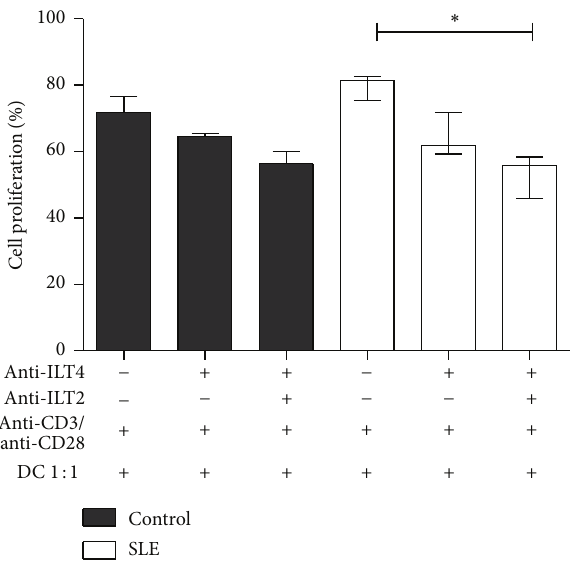
Figure 5: Effect of ILT4 engagement on the immunogenic activity of DC from patients with SLE. Mature DC were incubated in the presence or absence of anti-ILT4 and/or ILT2 agonistic mAb (aILT4/ILT2) and then cocultured with allogenic CFSE labeled PBMC, in flat-bottomed 96-well plates precoated with a mixture of anti-CD3 and anti-CD28 mAb. At day 5, cells were harvested and analyzed by flow cytometry. Percentage of cell proliferation was calculated as follows: % of proliferation = 100 − ((% cells in nonstimulated culture/% cells in stimulated culture) × 100). Empty bars correspond to healthy controls, and filled bars to SLE patients. Median and interquartile range of the data is shown. ∗ 𝑝 < 0.05